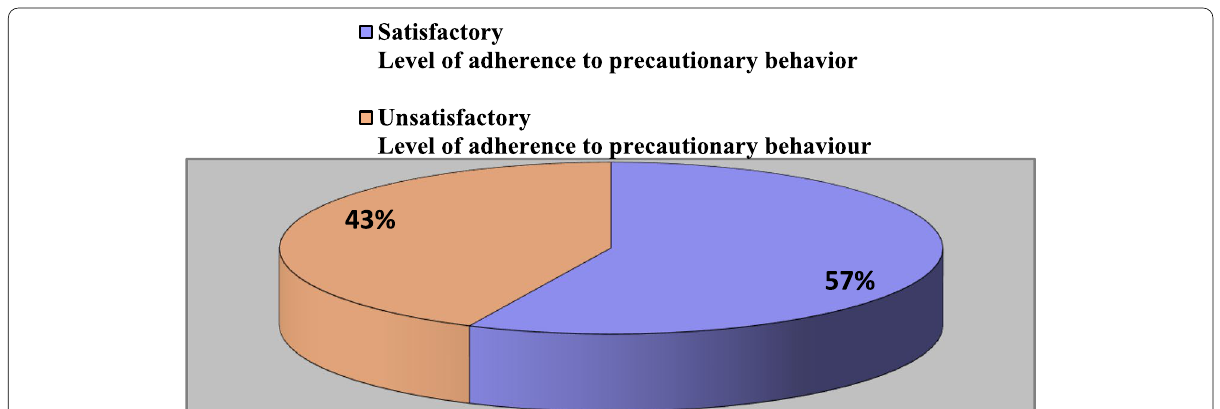
Fig. 2 Level of adherence to COVID-19 precautionary behavior among the students of health sciences in Princess Nourah University, 2020 ( n